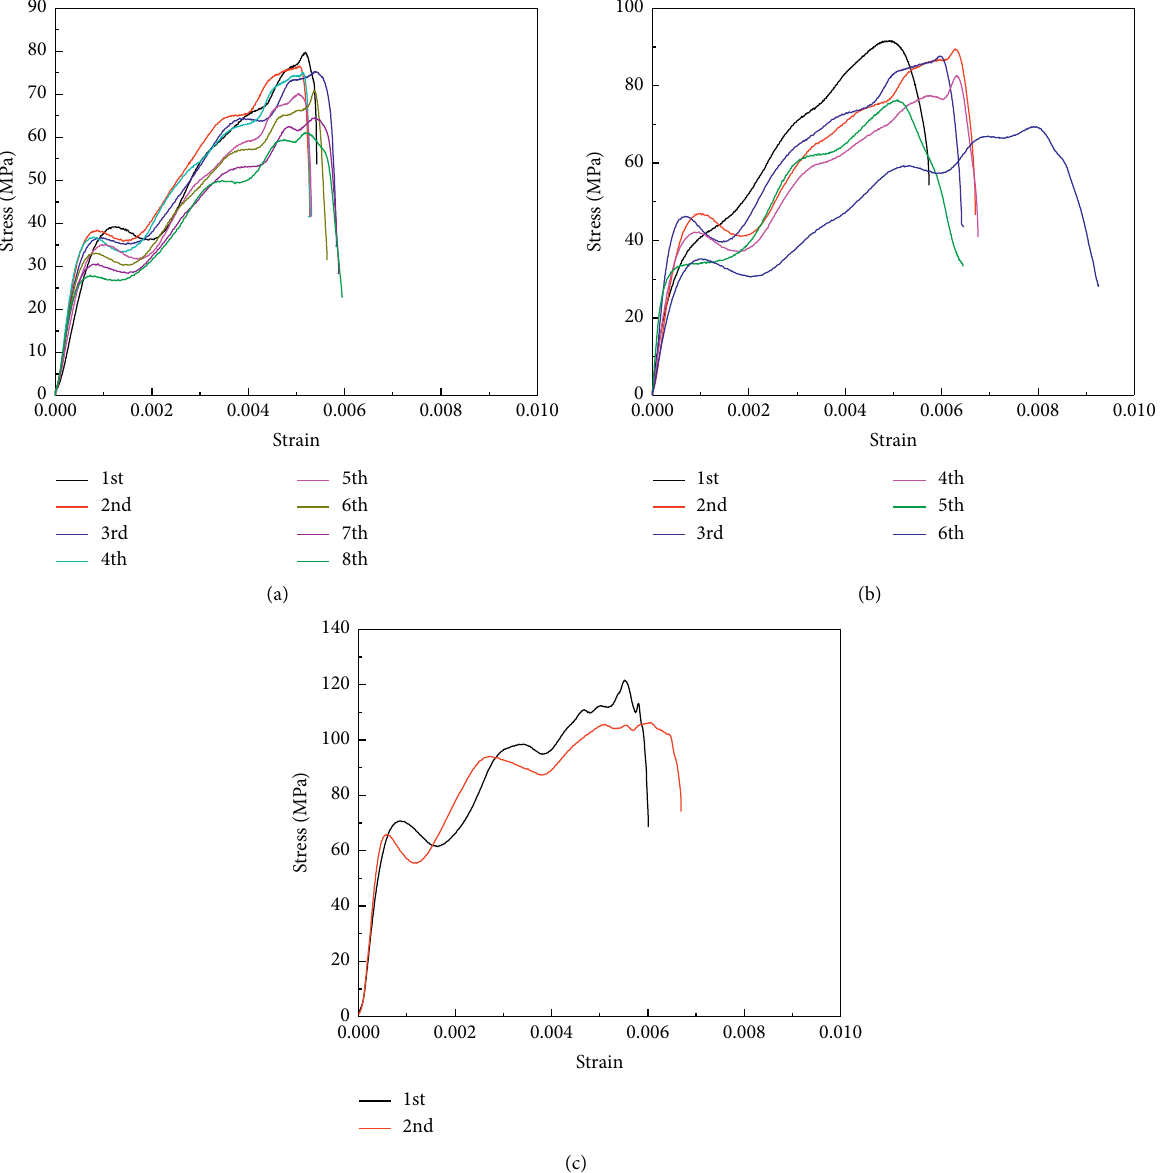
Figure 4: Stress-strain curves of sandstone under cyclic impact loads. (a) 6m/s. (b) 7m/s. (c)